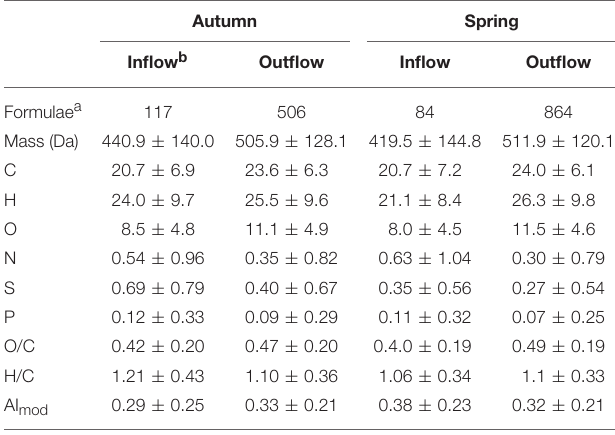
a Number of enriched molecular formulae (“Formulae”), intensity-weighted mean of molecular masses of enriched molecular formulae (“Mass,” in Dalton), intensity-weighted meansofthenumberofatomspermolecularformula(C,H,O,N,S,P),molarratios(O/C, H/C), and of aromaticity index (AI mod ). b Inflowing North Sea bottom water (17–19m depth) and outflowing Baltic Sea surface water at station S4 (Kattegat, see Figure 1 for sampling positions).